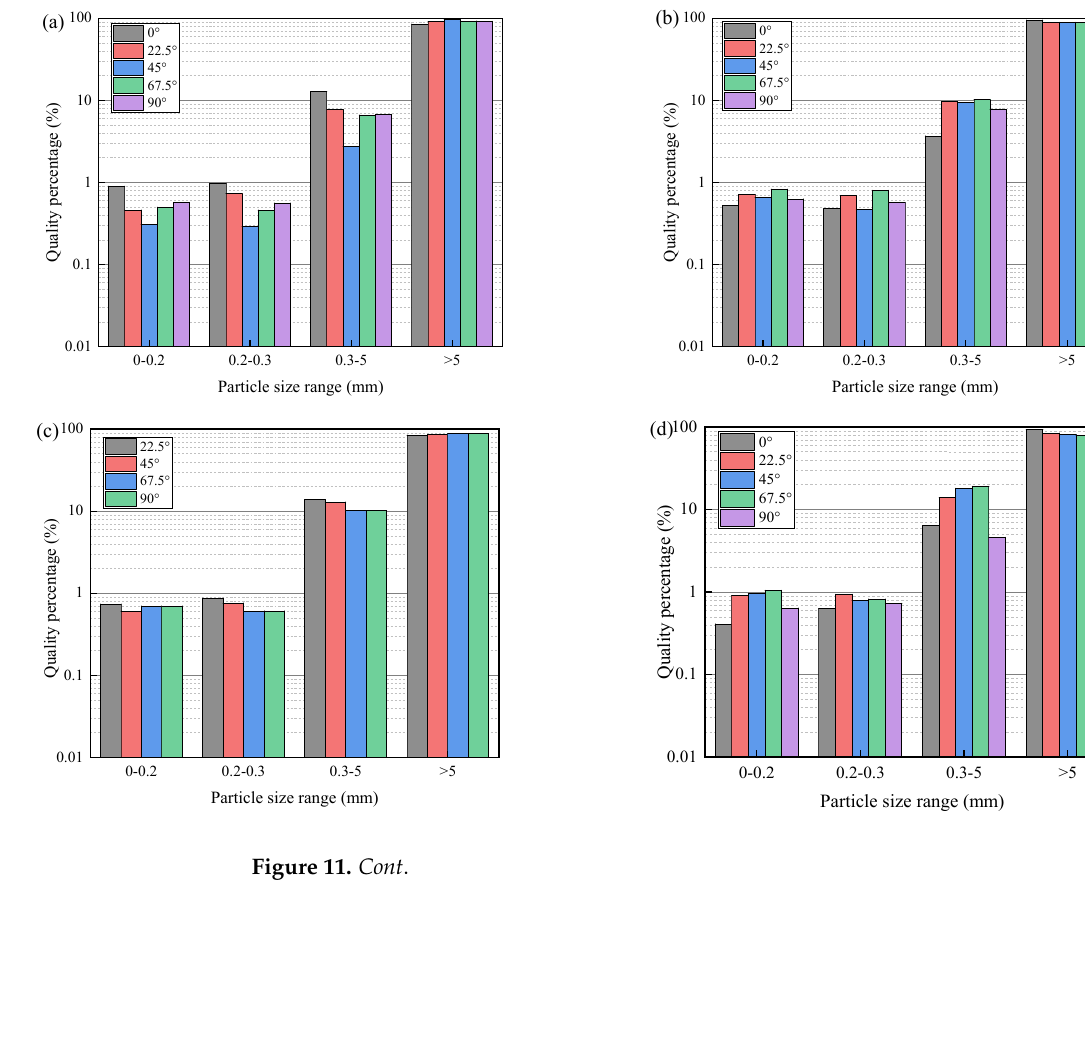
Figure 11. Percentage mass distribution of debris particle size at different lamination angles. ( a ) v = 1.737 m/s, ( b ) v = 2.351 m/s, ( c ) v = 2.728 m/s, ( d ) v = 3.309 m/s, and ( e ) v = 4.008 m/s. For coal rock fragments with a particle size greater than 5 mm, the fragment scale ratio distribution is shown in Figure 12. In Figure 12a, for the specimen with the bedding orientation of 0°, the length ‐ to ‐ thickness ratio of the debris basically ranged from 1.3 to 6.3, with an average value of 2.64. It was concentrated in the range of 2 to 3.5, mainly in the form of lumpy debris, including some plate debris, with a representative size of L:W:D = 3:2:1 ( L , W and D are the length, width and density of the debris, respectively). In Figure 12b, for the specimen with the bedding orientation of 22.5°, the length ‐ to ‐ thickness ratio of the debris ranged from 1 to 5.7, with an average value of 2.54. It was mostly in the form of lumpy debris, with a representative size of L:W:D = 2.0:1.8:1.0. The specimen with a bedding orientation of 45° in Figure 12c had a length ‐ to ‐ thickness ratio of 1.7 to 5, with an average value of 3.08, with the largest number of plate debris and a slightly smaller num ‐ ber of block debris, and a representative size of L:W:D = 3:2:1. The specimen with a bed ‐ ding orientation of 67.5° in Figure 12d had a length ‐ to ‐ thickness ratio of 1.7 to 5, with an average value of 3.08. The specimen with a bedding orientation of 67.5°, the length to thickness ratio of the debris was mainly concentrated in the range of 1~3, with an average value of 1.99. It basically consisted of blocky debris, containing some plate debris, with a representative dimension of L:W:D = 2.0:1.5:1.0. The specimen with a bedding orientation of 90° in Figure 12e, the length to thickness ratio of the debris ranged from 1.3~5.2, with an average value of 2.66. It mainly consisted of blocky debris, containing some plate de ‐ bris, with a representative dimension of L:W:D =2.0:1.5:1.0. In addition, it contained plate debris with dimensions of L:W:D = 2.5:1.3:1.0.